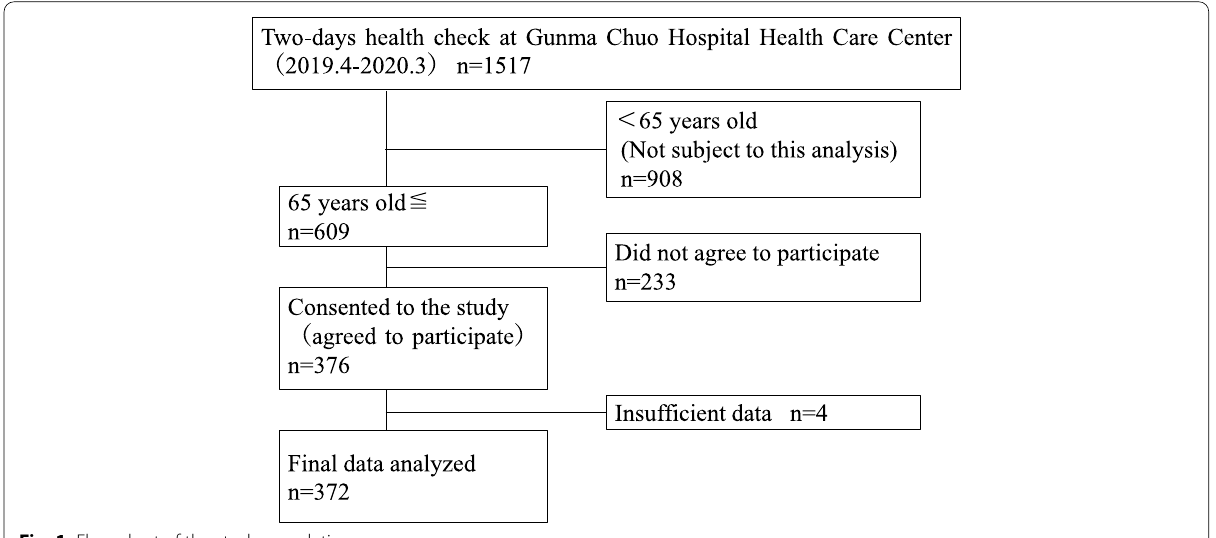
Fig. 1 Flow chart of the study